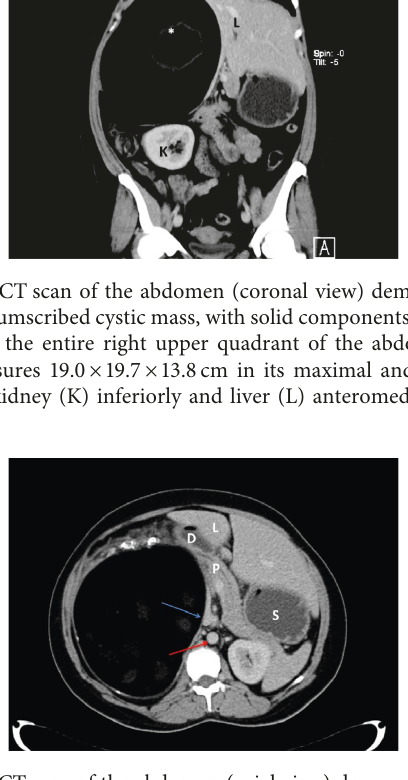
Figure 2: CT scan of the abdomen (axial view) demonstrating the complex cystic mass that appears to arise from the retroperitoneum and displaces the left liver (L), pancreatic head (P), duodenum (D), and inferior vena cava (blue arrow) anteromedially. For orienta- tion, the stomach (S) and aorta (red arrow) are labeled.